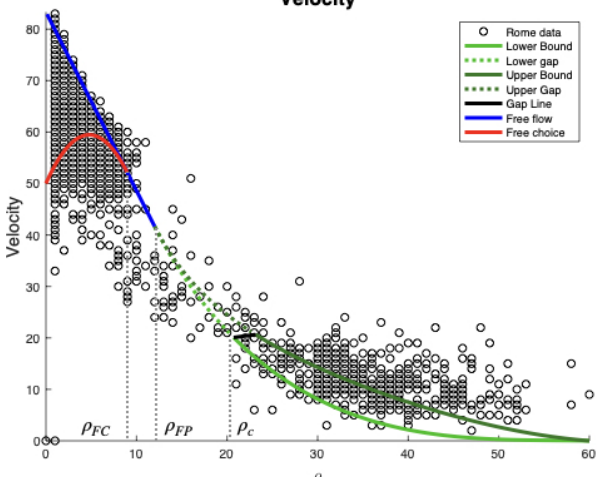
Figure 3. An example of speed function.